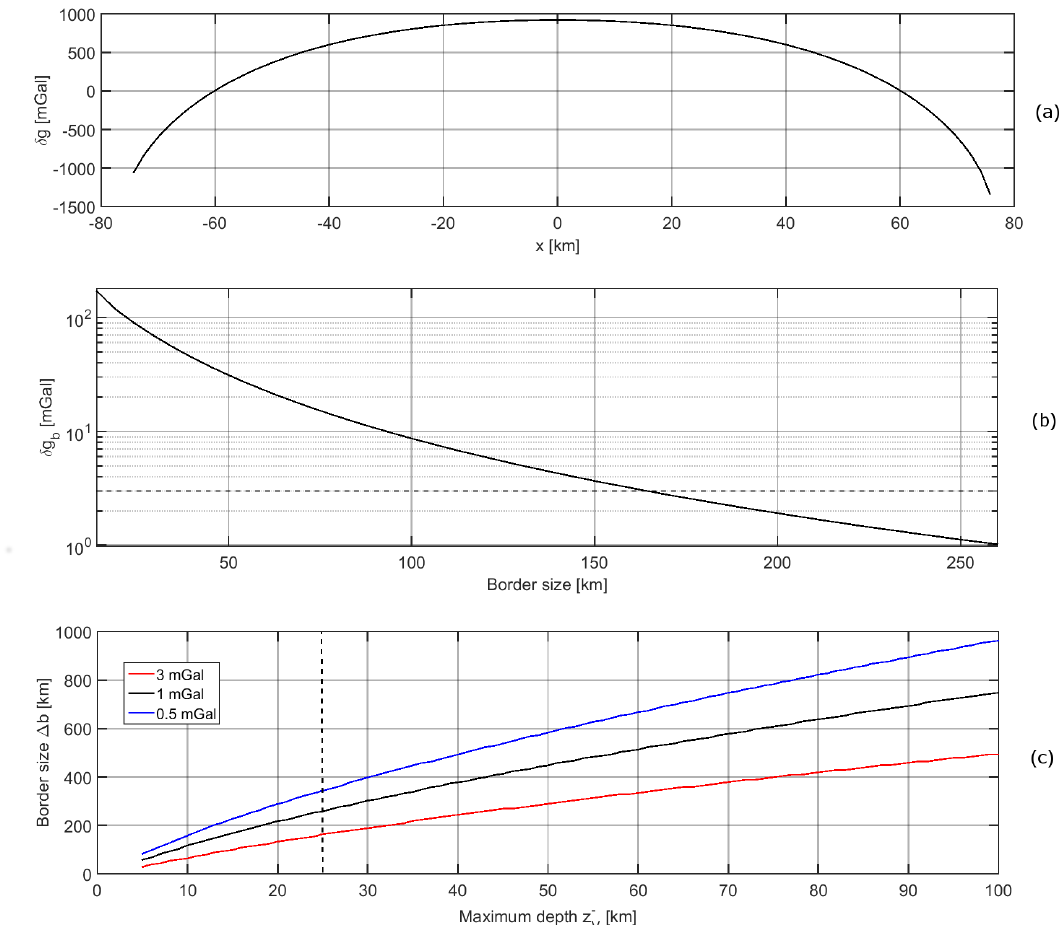
Figure 4. Gravitational effect generated by a volume V , with size 100 km in the x and y directions and = − 25 km with a constant density equal to 2670 kg m − 3 on a profile in the x direction at the center z − V of V ( a ); STD of the effect of the borders for the volume V as a function of the border size ( b ); border size ∆ b as a function of the maximum depth of V given different observation error STD ( c